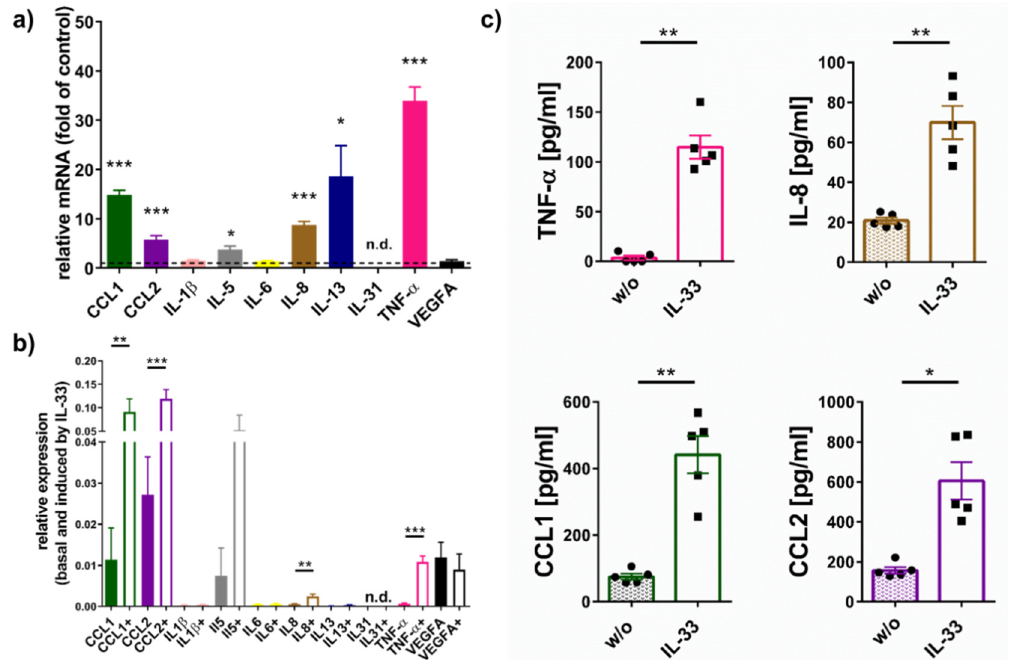
Figure 1. IL-33 triggers several cytokines in human skin mast cells (MCs). ( a ) Skin-derived MCs were stimulated for 90 min with IL-33 or kept in medium alone and harvested for mRNA quantification of different transcripts by RT-qPCR against a total of three housekeeping genes. A one sample t -test (against 1) was performed for each cytokine. ( b ) Uses the same dataset as in ( a ), with values normalized to actin as one exemplary housekeeping gene. Basal (plain cytokine name) and IL-33-induced (cytokine name followed by “+”) expression levels of cytokines analyzed by paired t -test for each cytokine entity. ( c ) MCs (at 1 × 10 6 cells/mL) in minimal medium were treated with IL-33 for 24 h when supernatants were collected, and cytokine proteins were quantified by ELISA. Paired t -tests were performed for comparison of IL-33 treatment to control (w/o). Each dot represents an independent MC preparation. Data are presented as mean of 5–7 experiments ± SEM. * p < 0.05, ** p < 0.01, *** p < 0.001 n.d. = not detectable.